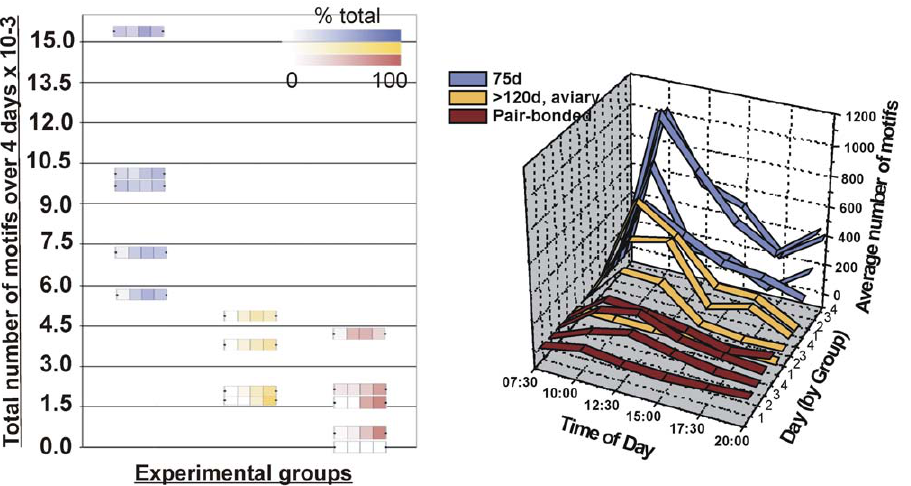
Figure 5. 75d birds practice more than adults. Data from 75d males (n=5) is shown in shades of purple, adult aviary males (n=4) in gold and adult pair-bonded males (n=5) in maroon. Left ) The amount of song sung while in sound attenuation chambers is shown. Individual data are plotted where squares represent days 2–5 (day one was not counted to allow for acclimation) and color intensity shows percent of total motifs sung each day. Compared with older birds, 75d males tended to sing on the first recording day and sang more overall (Mean 6 SEM in secs: 75d=12,958 6 1,731, adult aviary males=4,494 6 1,042, adult pair-bonded males=2,034 6 894; Kruskal-Wallis H =10.7, DF=2, p , 0.005). Right ) The daily pattern of singing is shown. For each group, the average number of motifs (z axis) is plotted in 2.5 hour time-blocks (x axis) across the 4 days. Each day is represented by one ribbon on the y axis and the 4 days are clustered by group.